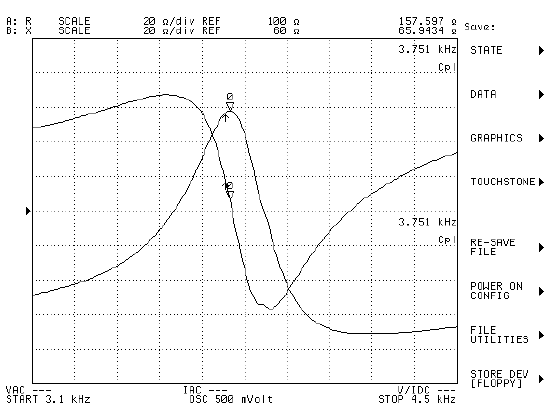
Figure 11. The impedance curves of the Terfenol-D transducer in water (obtained via Agilent 4294A).